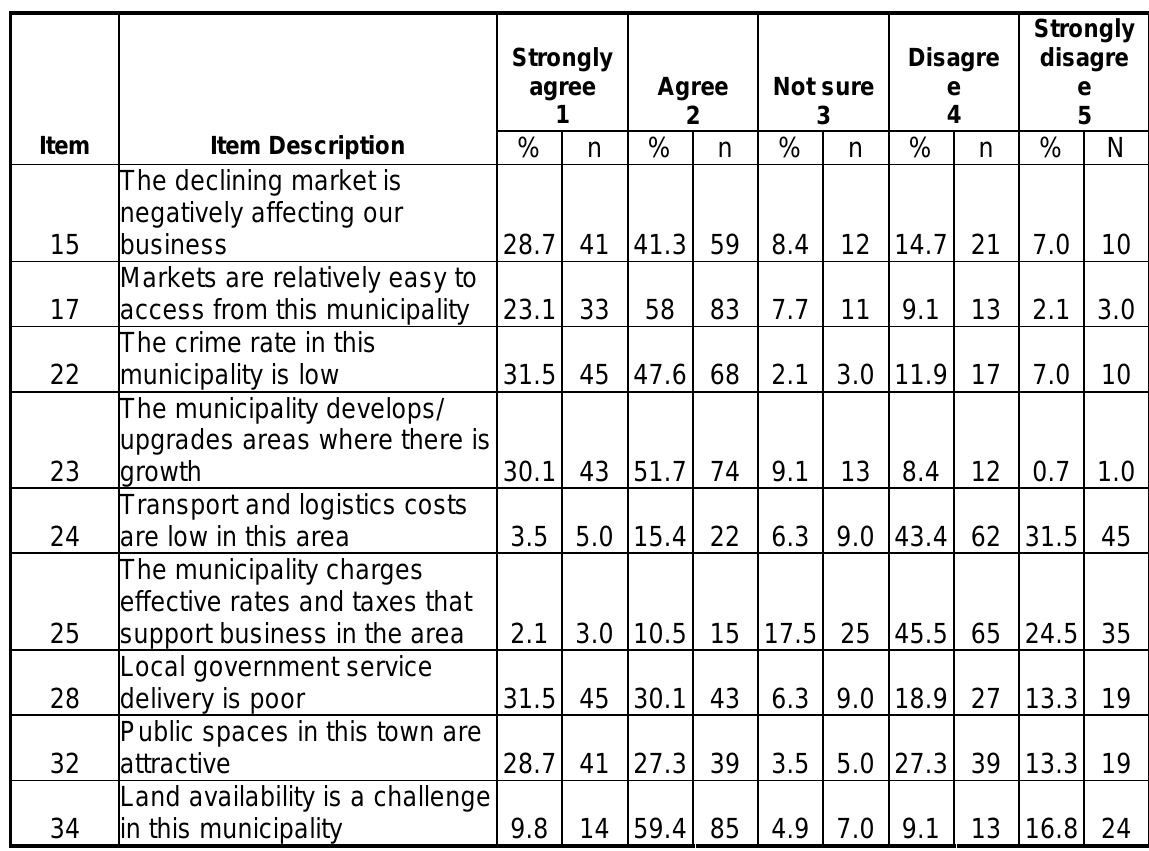
Strongly Strongly Disagre disagre e agree Agree Not sure e 1 4 5 2 3